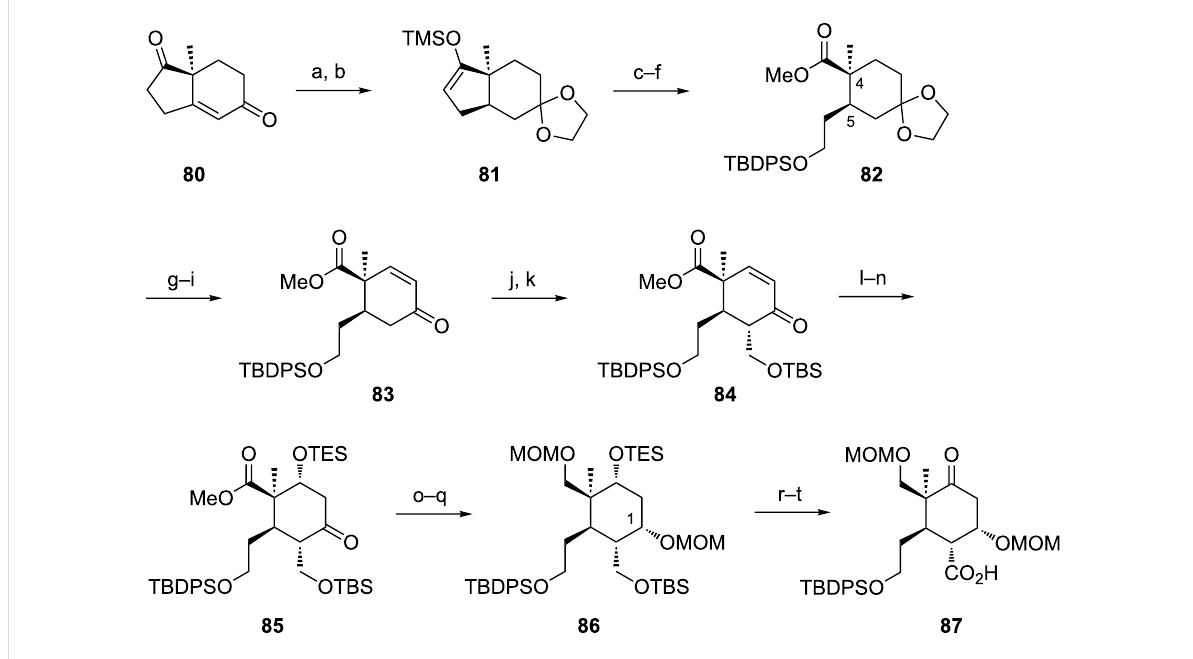
Figure 3a: electrostatic interaction with -OMOM at C14), this approach is slightly